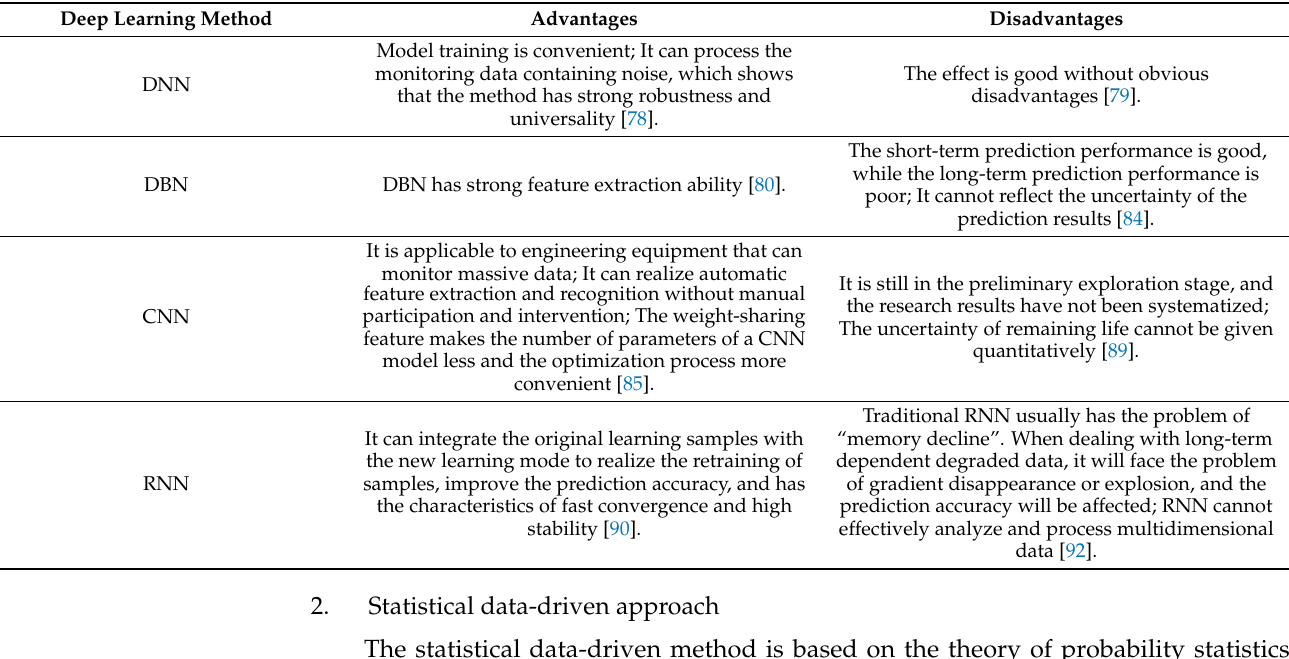
Table 6. Classification and characteristics of deep learning remaining life prediction